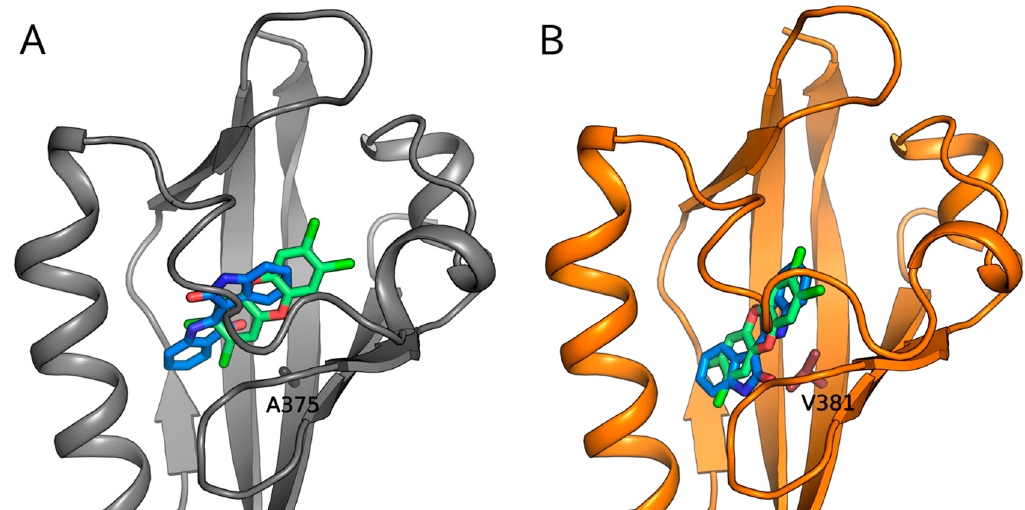
Figure 8. Binding geometries of TCDD (light green) and indirubin (marine blue) predicted by molecular docking to the AhR PASB LBD homology models. ( A ) mAhR in grey and ( B ) hAhR in orange. The nonconserved internal residues A375/V381 are shown as sticks.